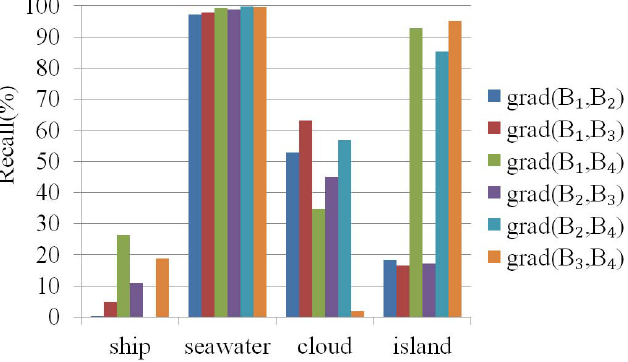
Figure 7. Performance of classification based on every single feature.